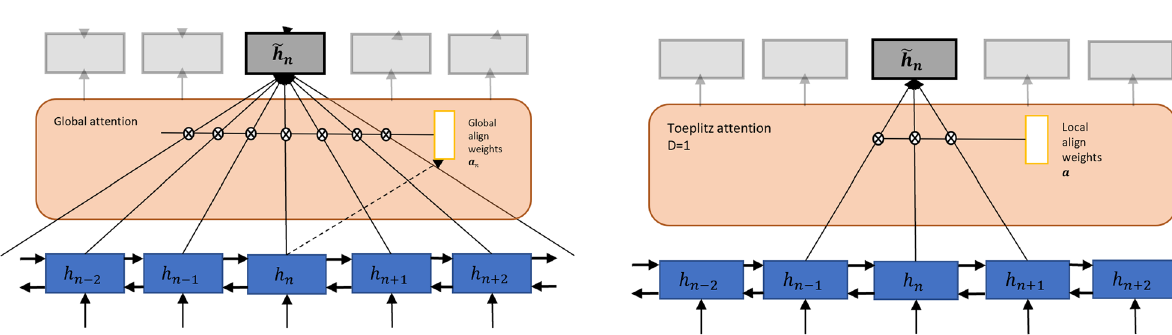
Figure 3. (left) Attention module allows fusion of GRU embeddings of different slices. (right) When no ˜ h attention is applied ( n = h n ) model is equivalent to full-sequence RCN 29 .